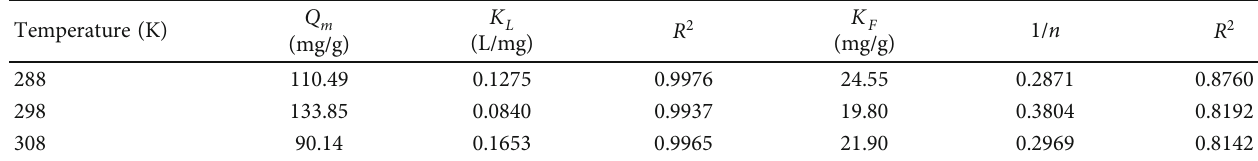
Table 6: Constants of Langmuir and Freundlich isotherm models for Cr (VI) removal of CSBT. Temperature